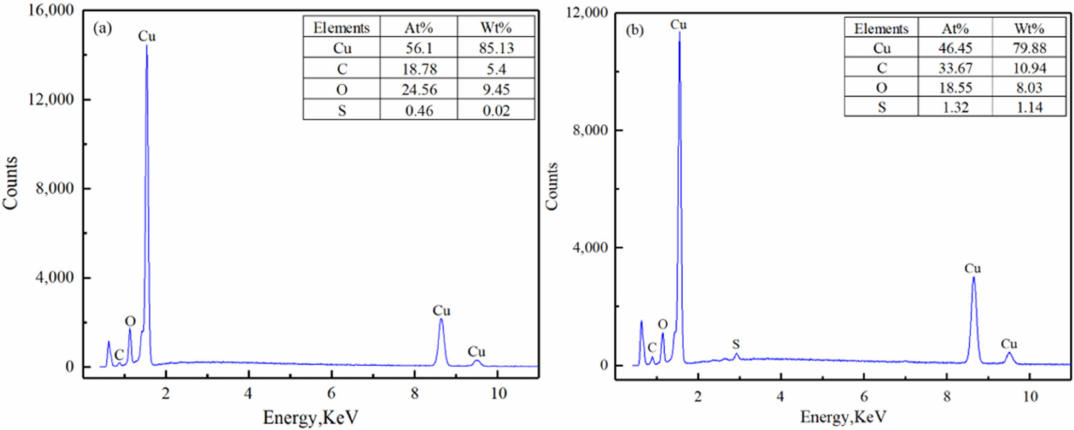
Figure 11. EDS spectrum of azurite: ( a ) before CDDP treatment; ( b ) after CDDP